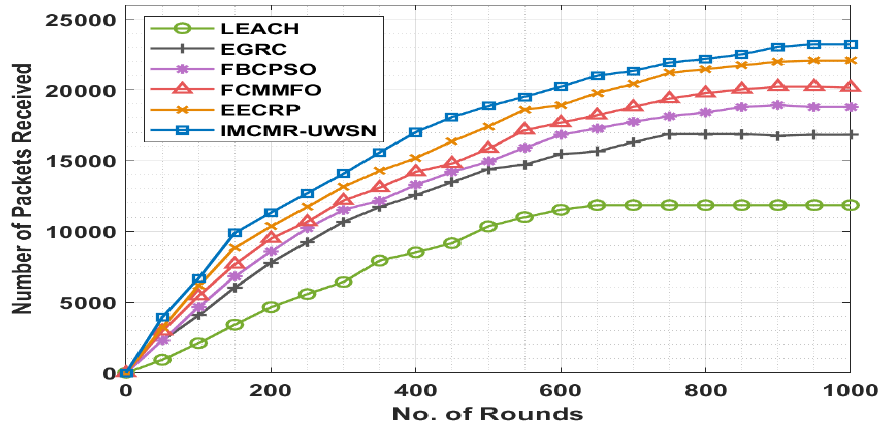
Figure 7. NOPR analysis of the IMCMR-UWSN technique.